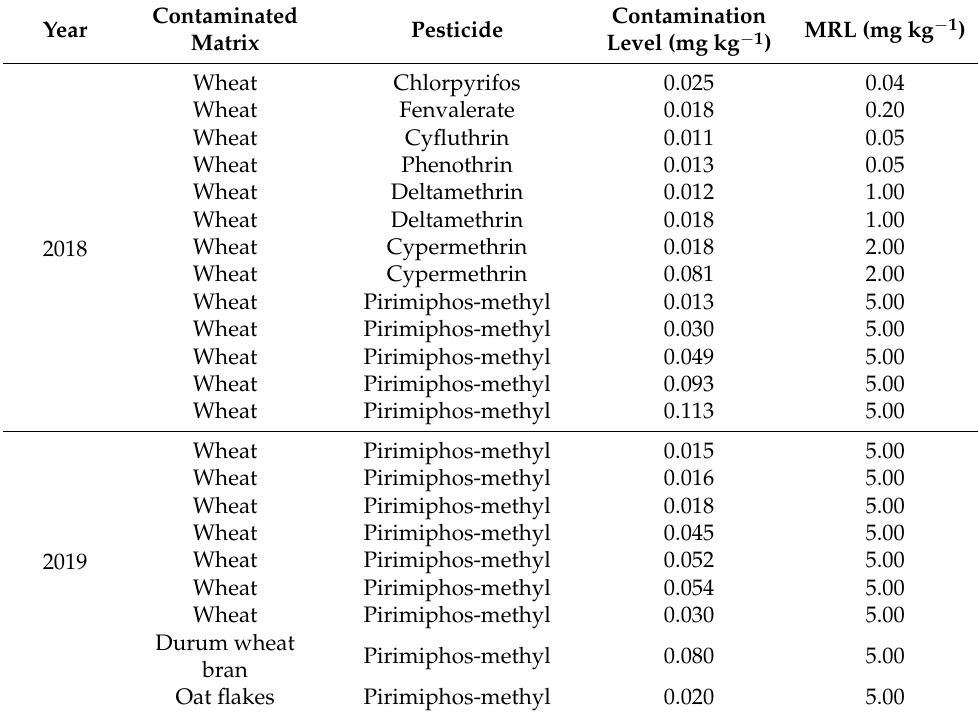
Table 3. Contaminated samples by pesticide residues and corresponding